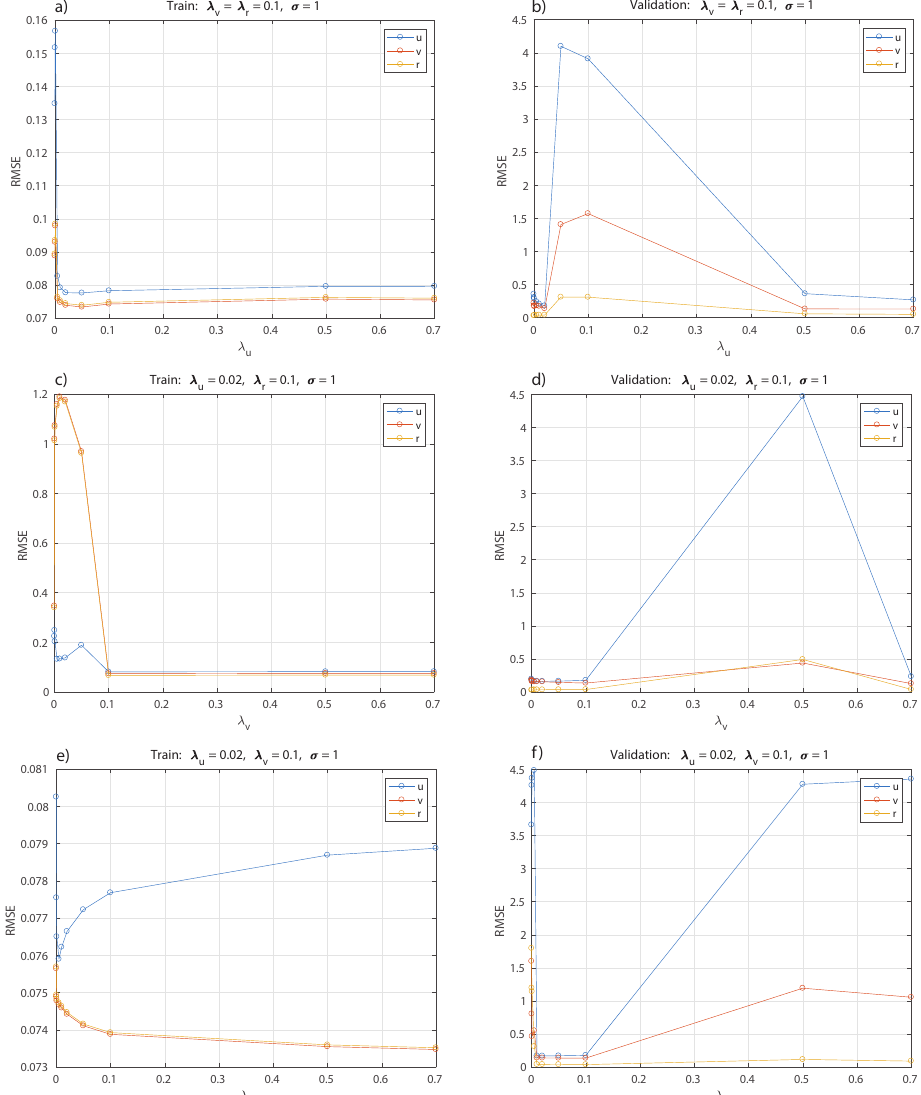
Figure 5. λ -parameter selection for kernel RBF. The units for the RMSE curves in all subplots are m / s for surge speed ( u ) and sway speed ( v ), and rad/s for the yaw rate ( r ). The best values correspond to λ u = 0.02, λ v = λ r = 0.1. Now, keeping these values fixed, a range of values for σ u , σ v , and, σ r is tested; see Figure 6, with the best results obtained for σ u = 1. For simplification, only the result for σ u is shown as the analysis applies the same value for σ v and σ r , since changing the parameter for each model does not show a significant difference. The polynomial kernel shows acceptable results with degrees p = 1, p = 2 using constant parameters c = 1 and θ = 1. The values used for λ u , λ v , λ r are the same as the best result from the previous analysis for kernel